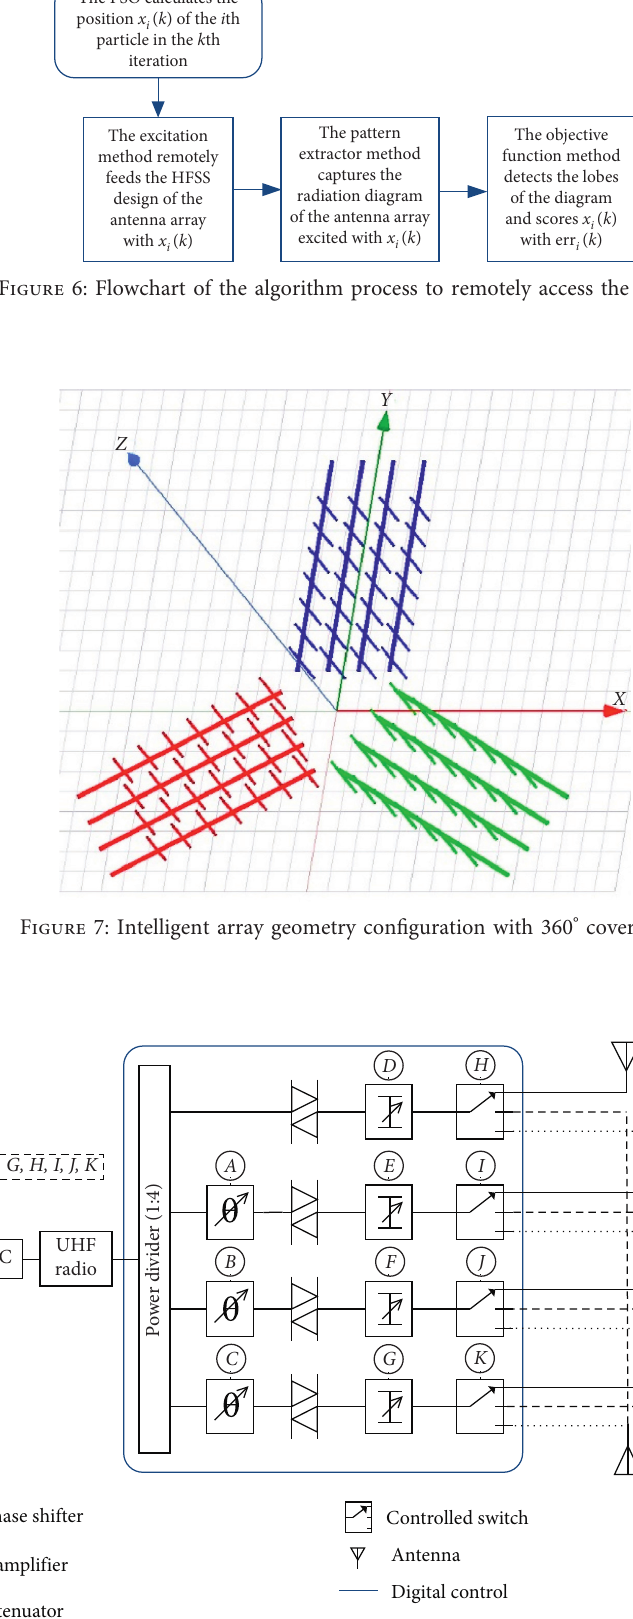
Figure 8: Complete system configuration for the antenna